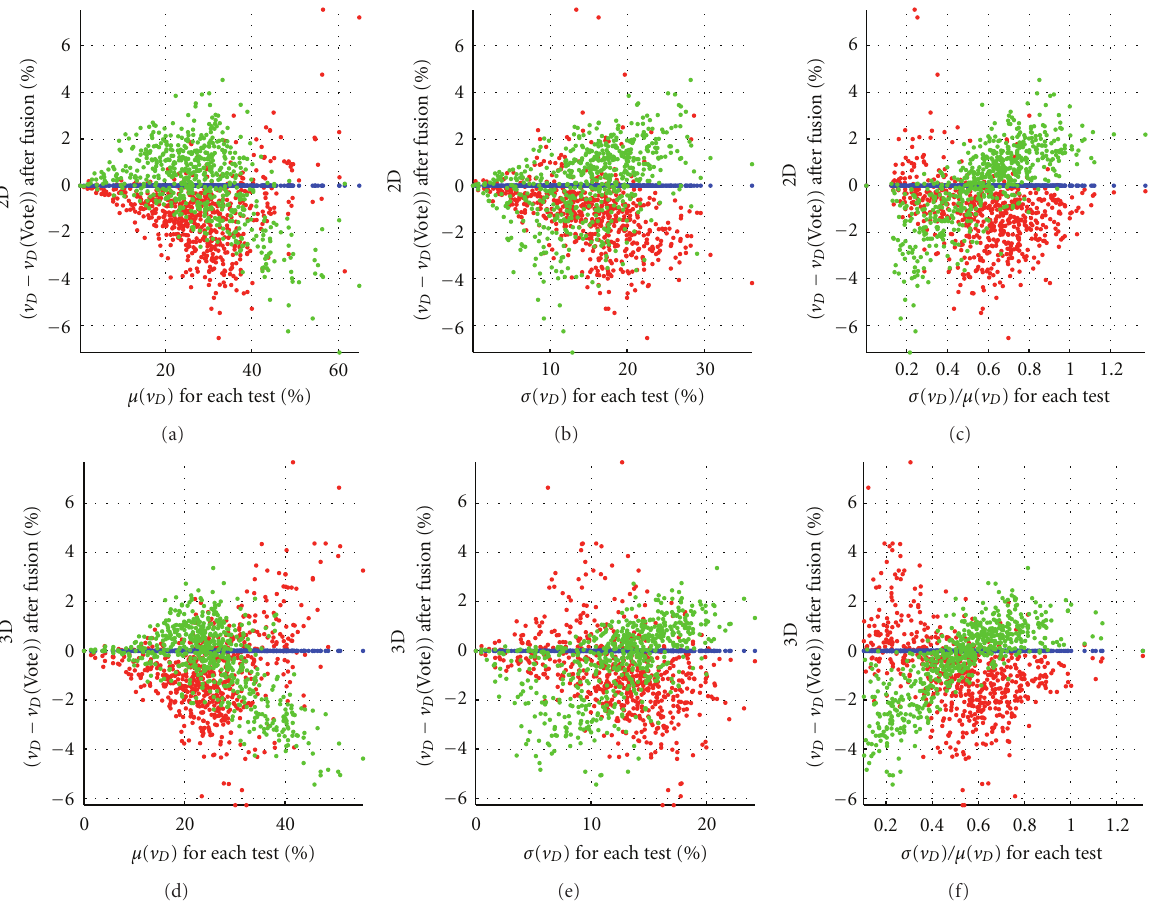
Figure 2: Scatter plots showing v D centered on the Vote’s values, i.e. ( v D − v D (Vote)), obtained after label fusion with STAPLE (red), Vote (blue), and SBA (green) of the 625 tests of the (a, b, and c) 2D and (d, e, and f) 3D training sets, with respect to each test’s (a, d) mean ( μ ( v D )), (b, e) standard deviation ( σ ( v D )), and (c, f) coe ffi cient of variation ( σ ( v D ) /μ ( v D )) of v D , calculated over the input labels for each test. The centered v D corresponds to v D minus the v D evaluated for Vote. We note that σ ( v D ) /μ ( v D ) better discriminates the label fusion methods than σ ( v D